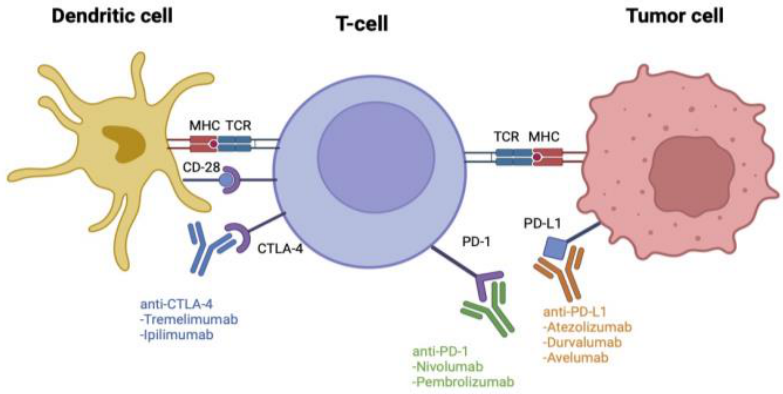
Figure 1. The mechanism of action of ICIs. Abbreviations: ICIs, immune checkpoint inhibitors; MHC, major histocompatibility complex; TCR, T-cell receptor; CD-28, cluster of differentiation 28; CTLA-4, cytotoxic T-lymphocyte antigen 4; PD-1, programmed cell death protein 1; PD-L1, programmed cell death protein ligand 1.